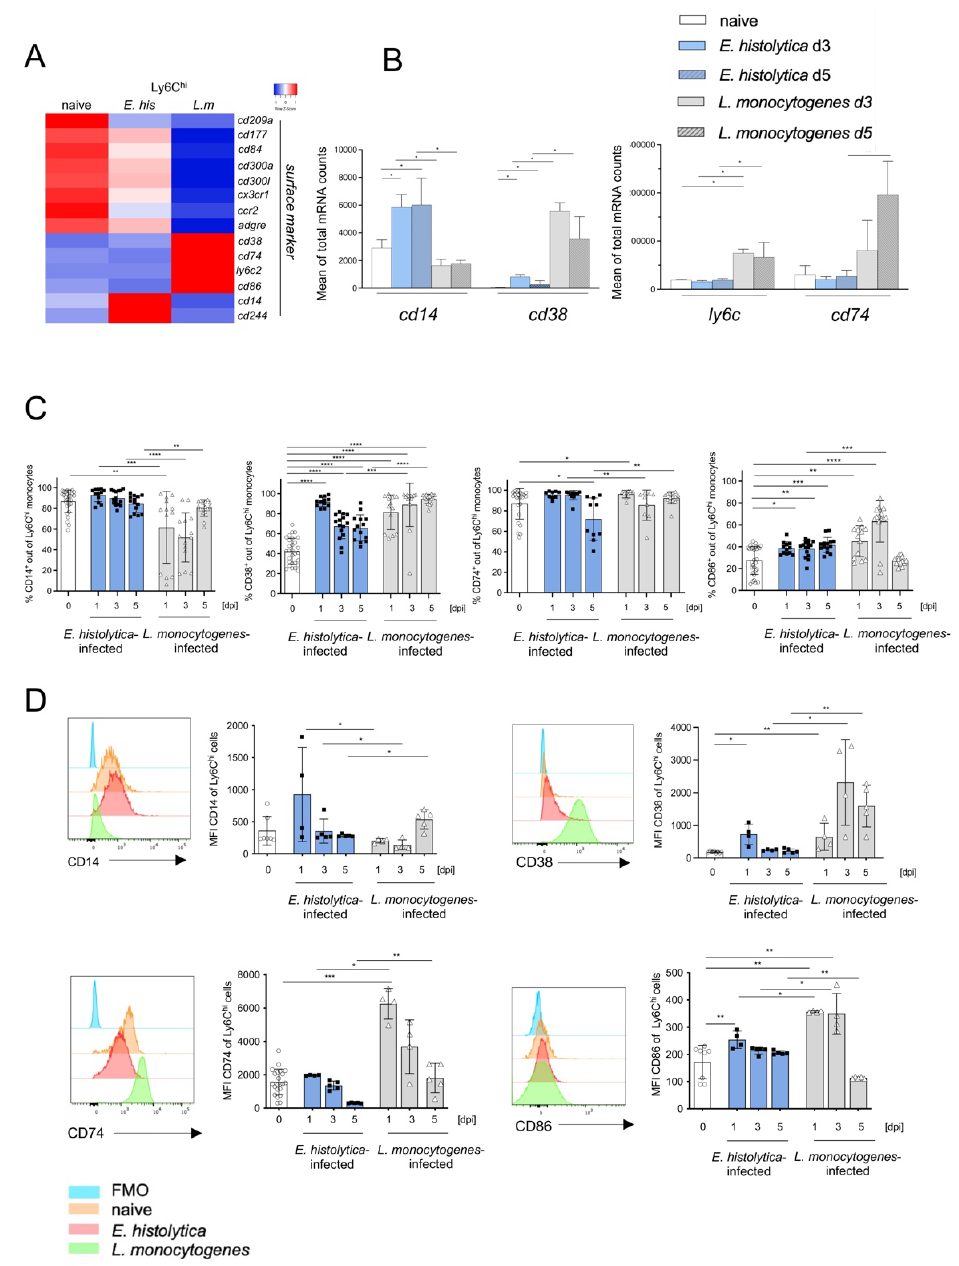
Figure 4. Marked differences in expression of surface markers by Ly6C hi monocytes after infection with E. histolytica or L. monocytogenes ( A ) Heatmap depicting differential expression of mRNA en- coding selected markers on the surface of liver Ly6C hi monocytes after infection with E. histolytica ( E. his ) or L. monocytogenes ( L. m ). ( B ) Normalized mRNA counts of selected surface marker genes (from transcriptome analysis). ( C ) Percentage of CD14 + , CD38 + , CD74 + , and CD86 + Ly6C hi monocytes during the course of infection at the indicated time points post-infection (measured by flow cytometry). ( D ) Histogram and MFI of CD14 + , CD38 + , CD74 + , and CD86 + Ly6C hi monocytes during the course of infection. Data in C were pooled from three independent experiments. Data in D are representative of one of these three experiments and all data are presented as the mean ± SEM (* p < 0.05; ** p < 0.01; *** p < 0.001, **** p < 0.0001; Mann-Whitney U test). Overall, the results of the transcriptome analysis of surface marker expression, with the exception of CD74, are reflected at the protein level in vivo. Furthermore, they suggest that CD14 in combination with CD38 may be additional putative markers for a Ly6C hi